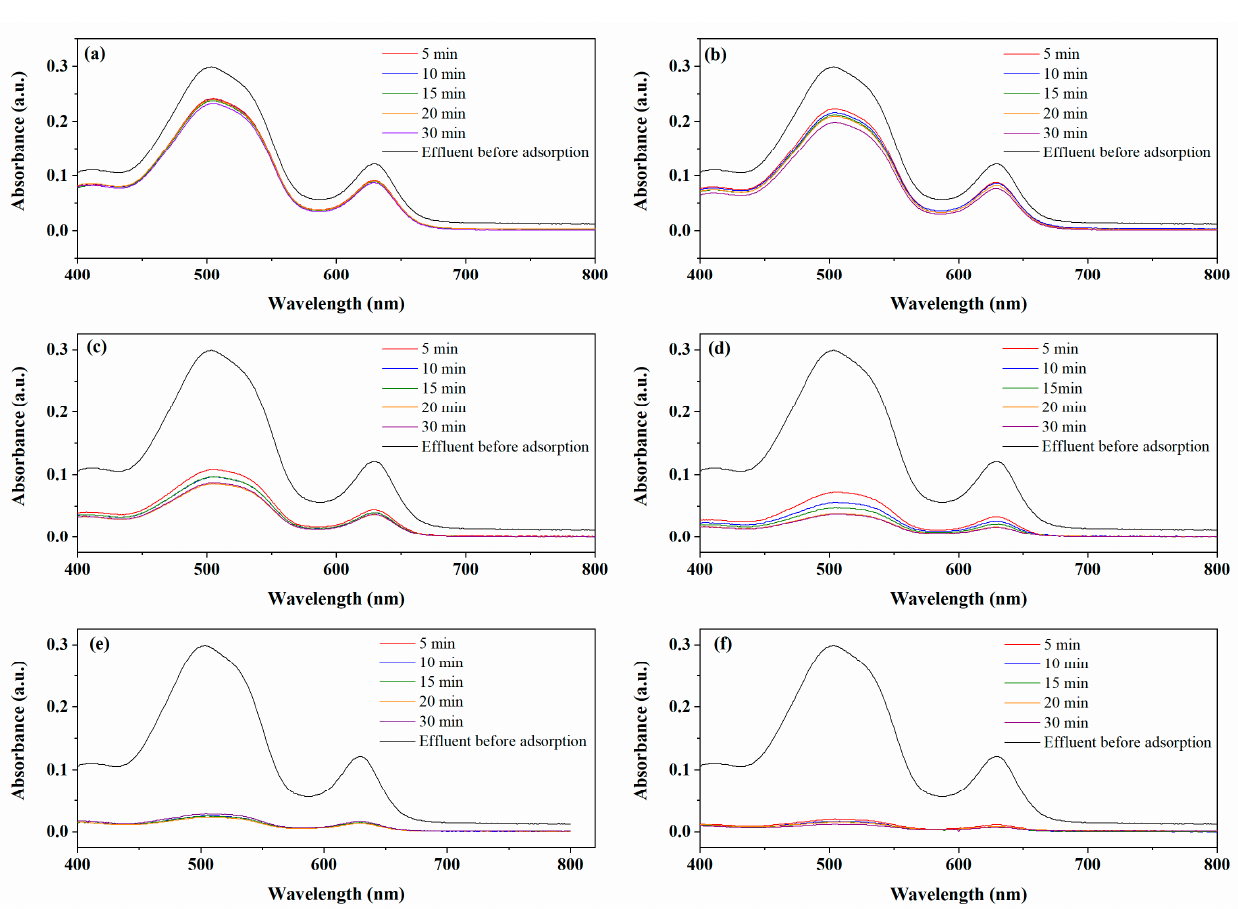
Figure 10. Absorption spectra of simulated effluent before and after adsorption with 1 g L − 1 : ( a ) MAC1105 and ( b ) MAC111; 5 g L − 1 : ( c ) MAC1105 and ( d ) MAC111; 10 g L − 1 : ( e ) MAC1105 and ( f ) MAC111.